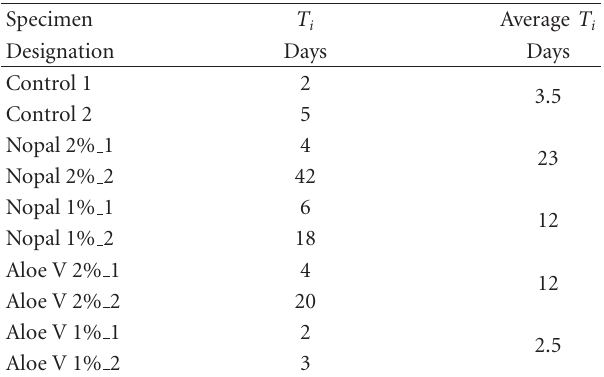
Figure 9: Time for corrosion initiation, T i , for all specimens tested in the second set. Table 1: Time of corrosion initiation ( T i ) for each rebar tested in the first set of